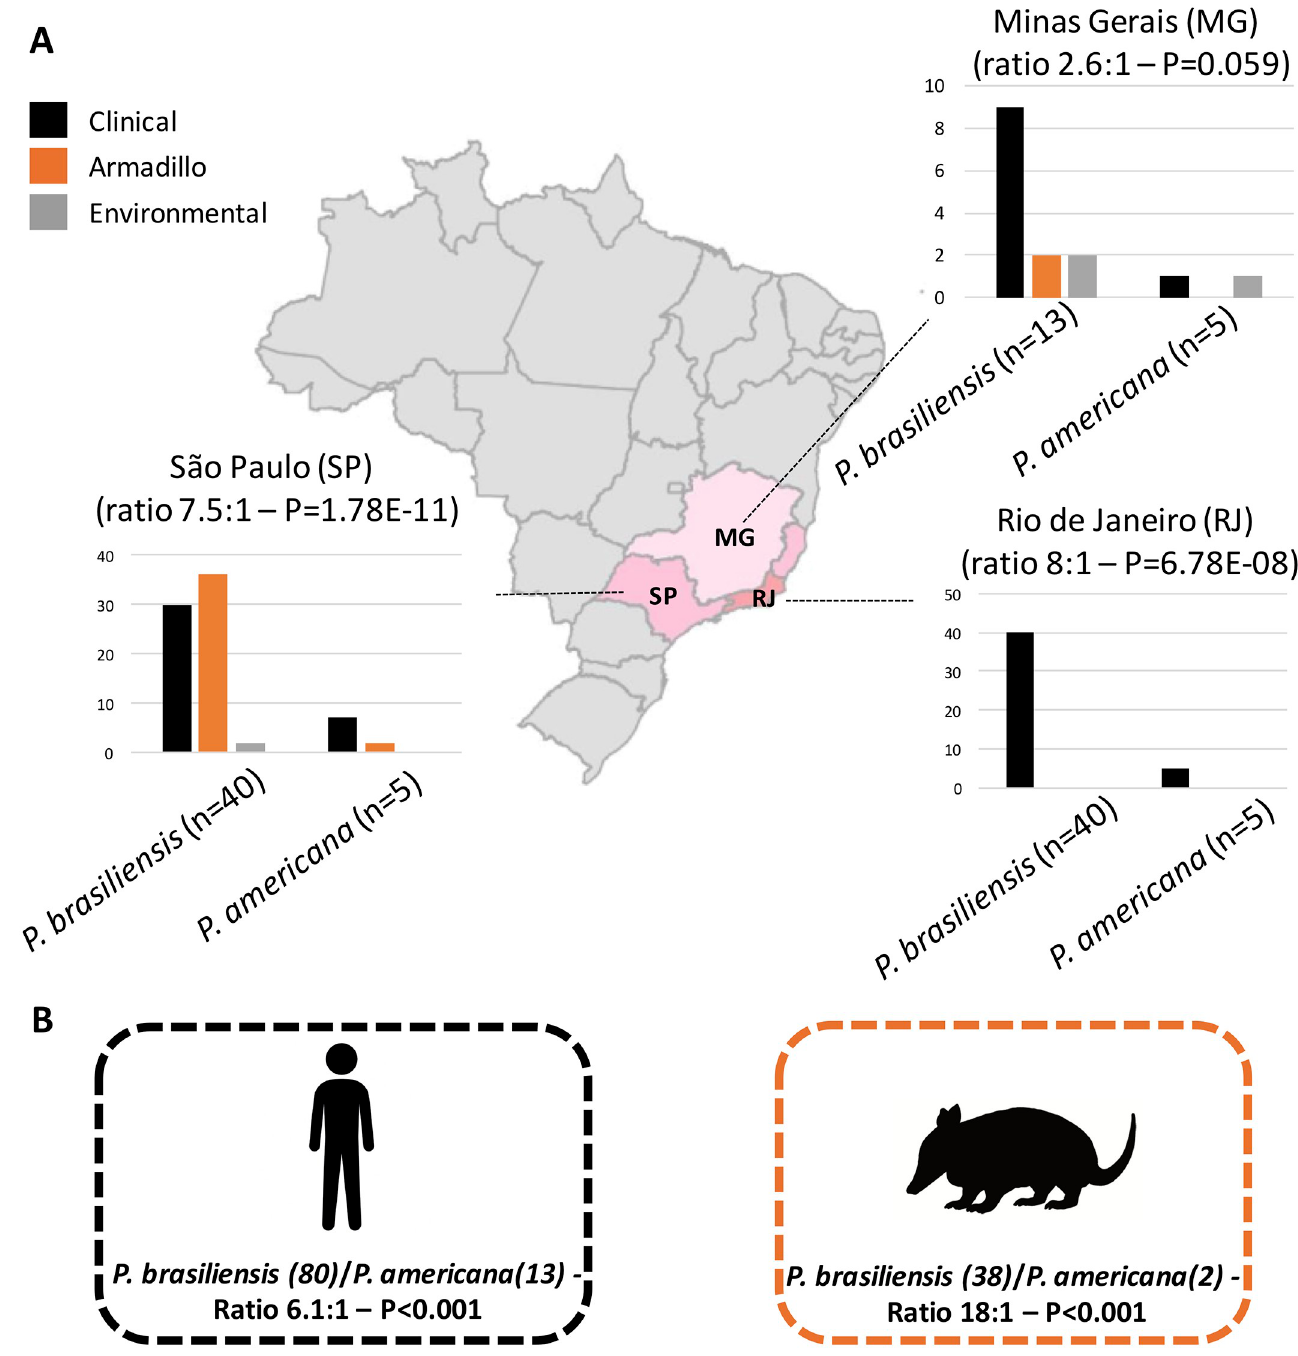
Fig 5. Paracoccidioides brasiliensis/Paracoccidioides americana ratio among environmental, human, and armadillo strains. (A) ratios of three states from the Southeastern Brazilian region, where the study was conducted: Minas Gerais (MG), Rio de Janeiro (RJ), and S ã o Paulo (SP). Graphs represent the number of identified strains from clinical (black bars), armadillos (orange bars), and environmental (gray bars) origins. (B) global ratios and number of human and armadillo P . brasiliensis and P . americana strains. Base map data from Brazilian Institute of Geography and Statistics (IBGE).